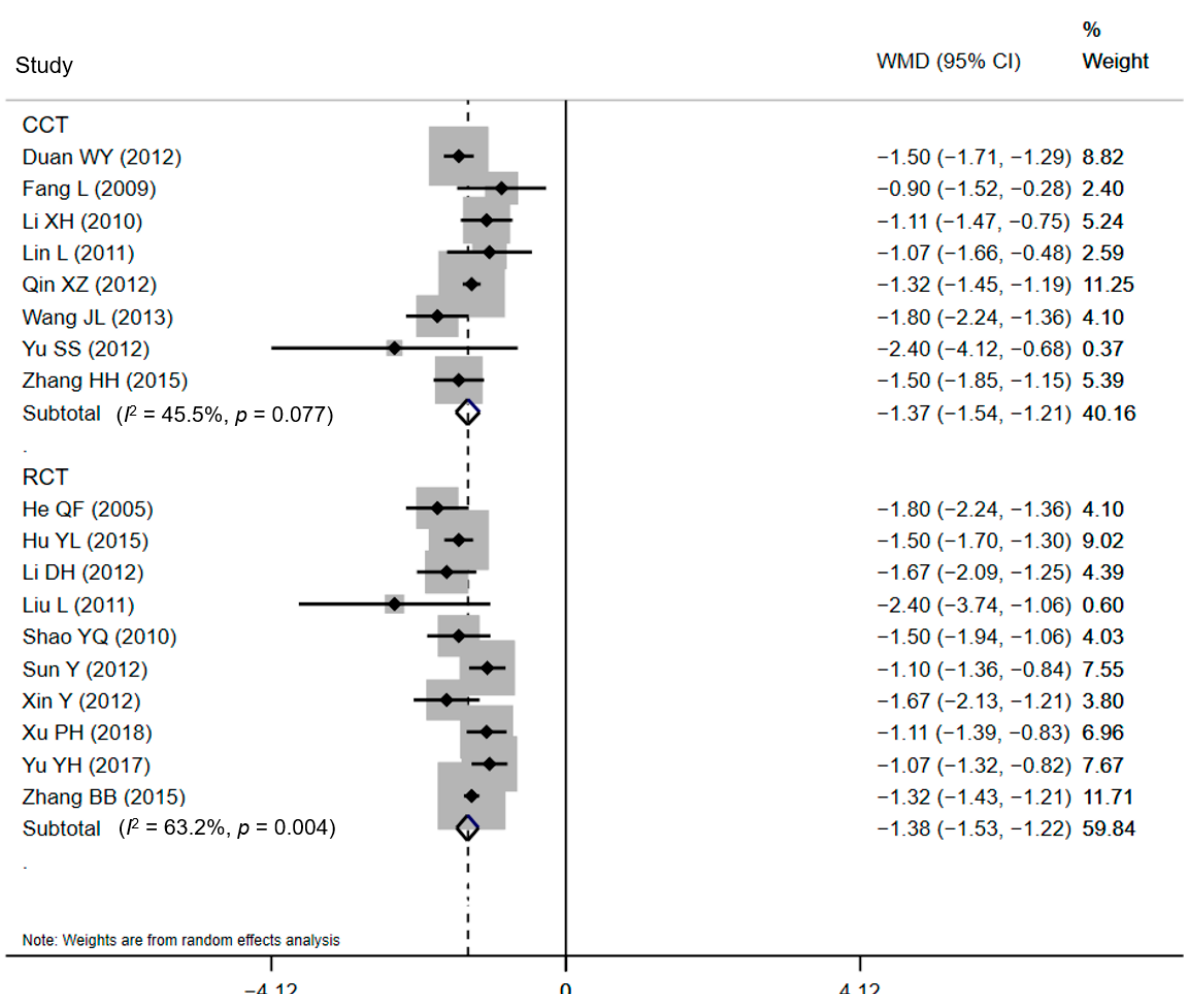
Figure 4. Forest plot of effects on LOS in different subgroups. Abbreviations: WMD, weighted mean difference; CI, confidential interval; LOS, length of stay.